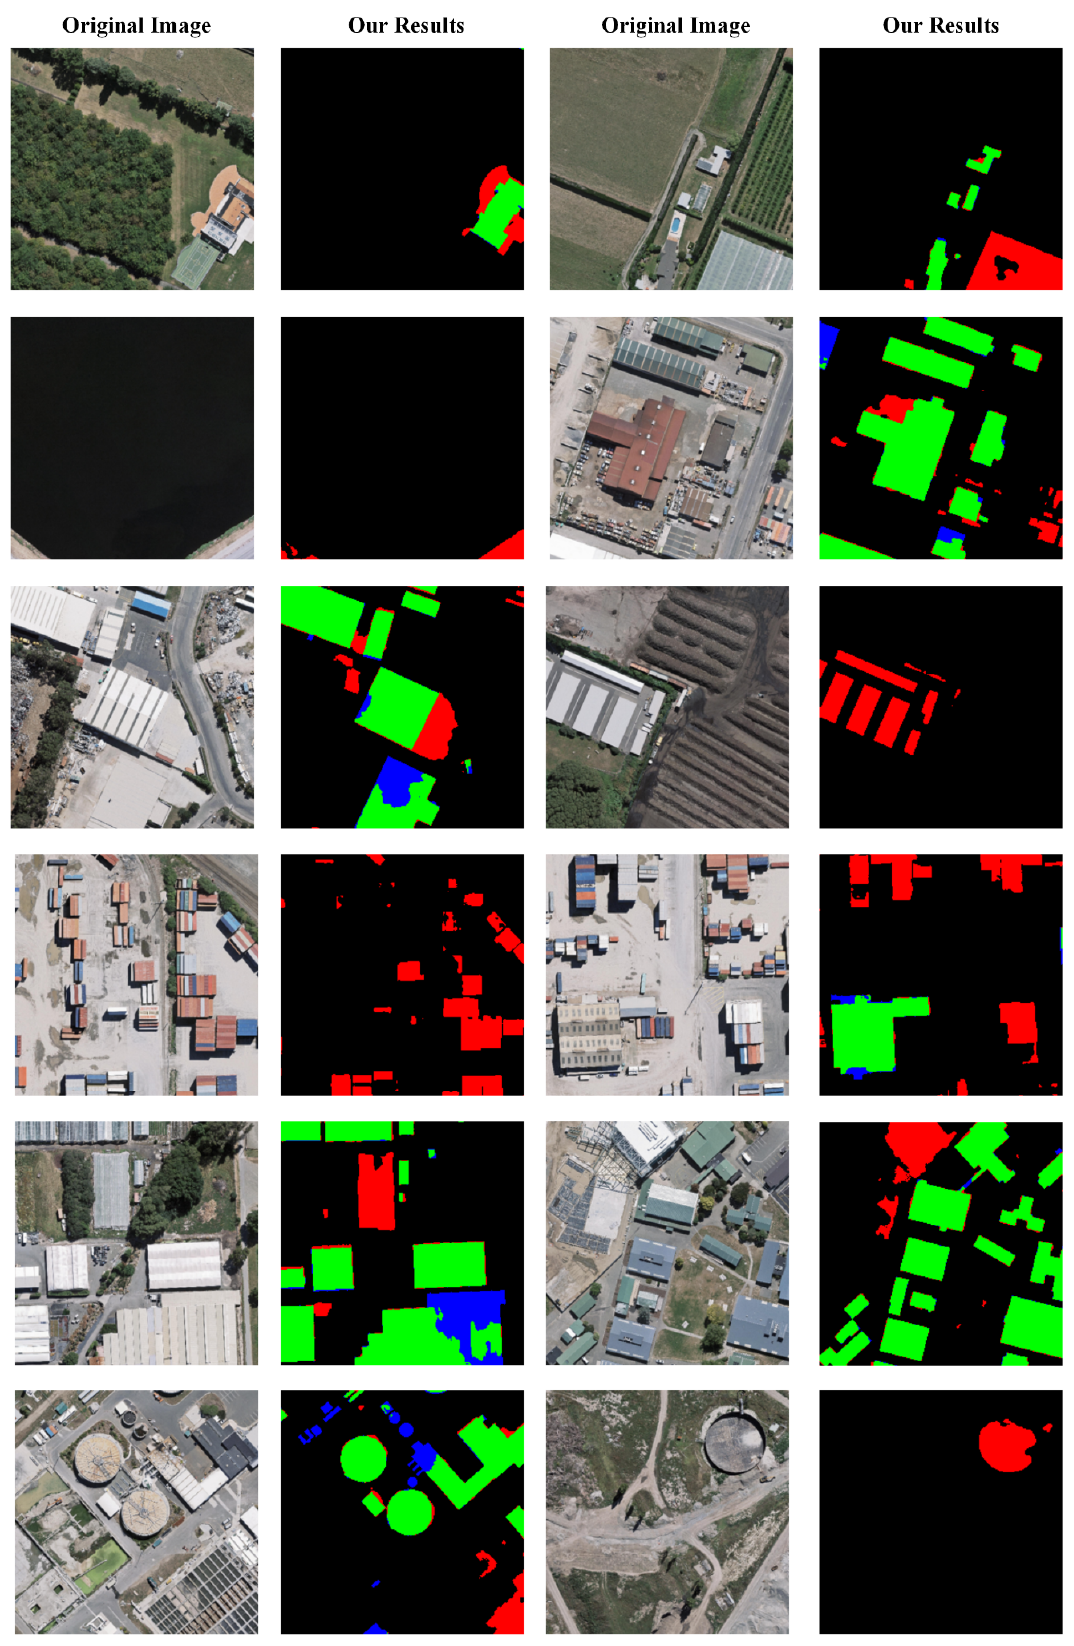
Figure 9. Major false positive exhibitions of our extraction results in the WHU dataset. The green, red and blue areas represent the right, false positive and false negative areas, respectively.